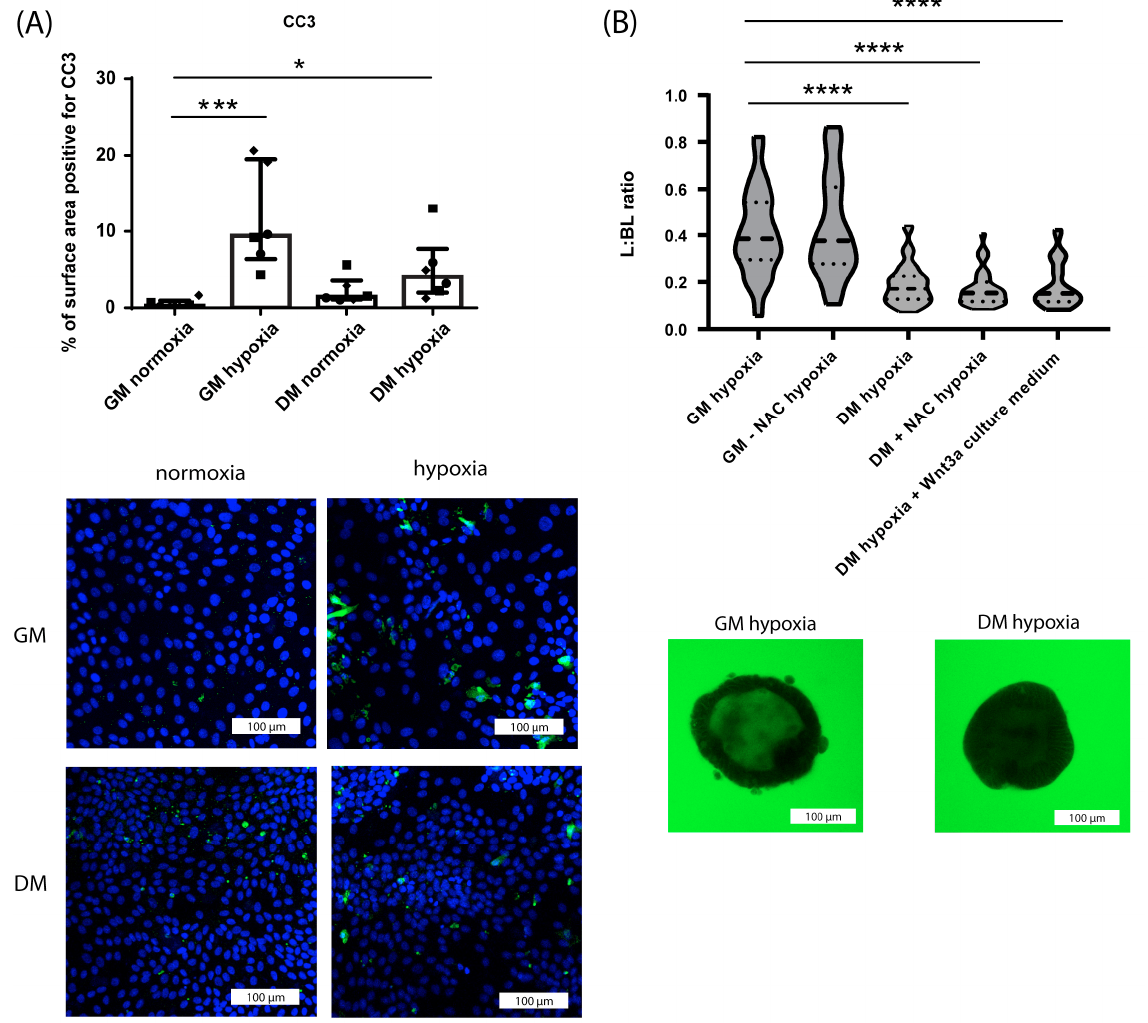
Figure 5. Differential effect of hypoxia on crypt-like and villus-like HIO (3D- and monolayer-cultured). ( A ) Analysis of the % of surface area positive for CC3 and representative images from immunofluorescence staining of CC3 in crypt-like and villus-like HIO monolayers exposed to hypoxia for 24 h compared to normoxic controls. Data are displayed as median with interquartile range. Results were obtained from three different HIO donors (depicted by different data point symbols, one symbol type per donor). Scale bars indicate 100 µ m. ( B ) FITC-D4 paracellular barrier assay of crypt-like (GM-cultured) and villus-like (DM-cultured) 3D HIO exposed to hypoxia for 16 h, in presence or absence of NAC and following replacement of the surplus of AdDF+++ in DM by the DMEM medium used for the production of Wnt3a-conditioned medium. Representative images of crypt-like (GM-cultured) and villus-like (DM-cultured) 3D HIO exposed to hypoxia for 16 h. FITC-D4 fluorescence intensity is expressed as a luminal (L) to basolateral (BL) ratio. Per group, 15 HIO were measured in 3 different donors. Scale bars indicate 100 µ m. * p 0.5, *** p 0.001, **** p 0.0001. ≤ ≤ ≤ Abbreviations: CC3—cleaved caspase